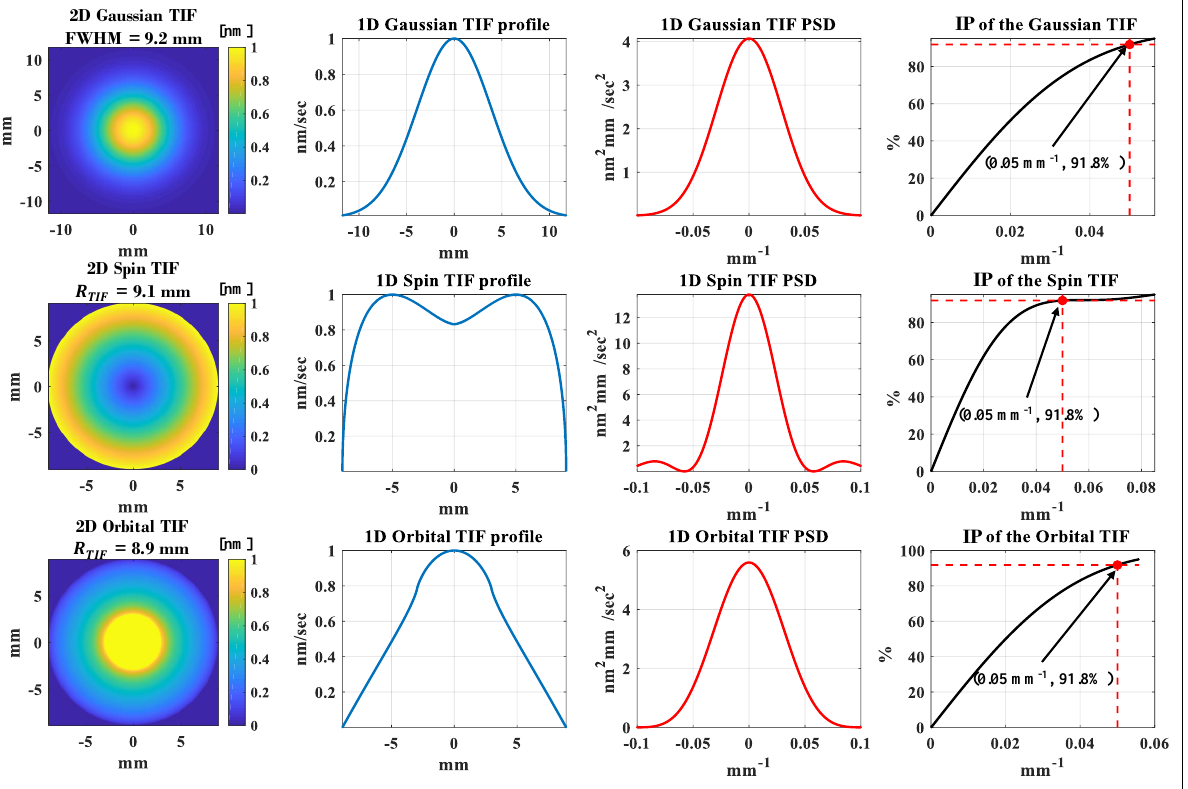
Figure 5. Typical TIFs scaled to have a characteristic frequency of f c = 0.05 mm −